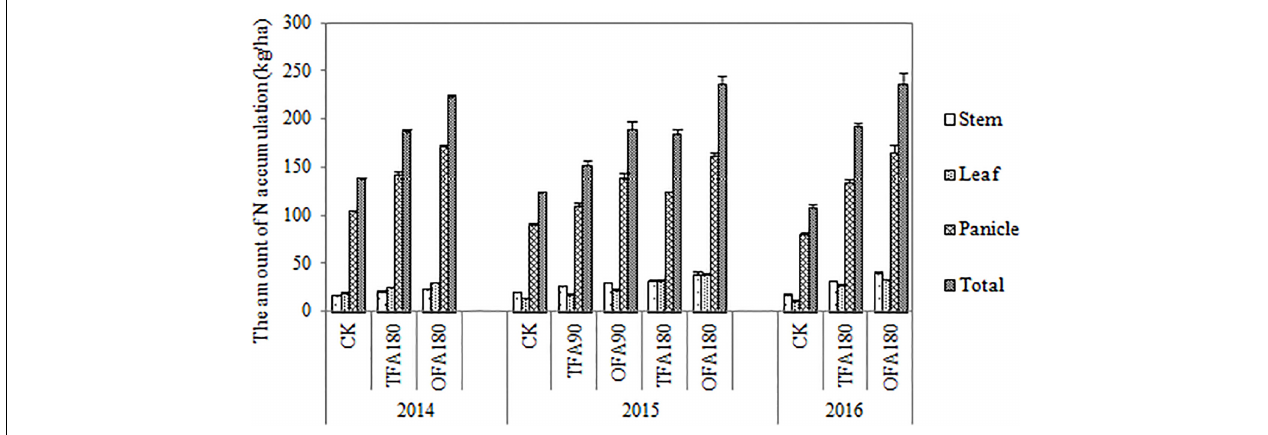
FIGURE 2 | Nitrogen accumulation in the various treatments. CK: No nitrogen applied; TFA: traditional nitrogen fertilizer application; OFA: optimized nitrogen fertilizer application; 90: total nitrogen application rate of 90 kg ha - 1 ; 180: total nitrogen application rate of 180 kg ha - 1 . Data represent mean values of three biological replicates ±